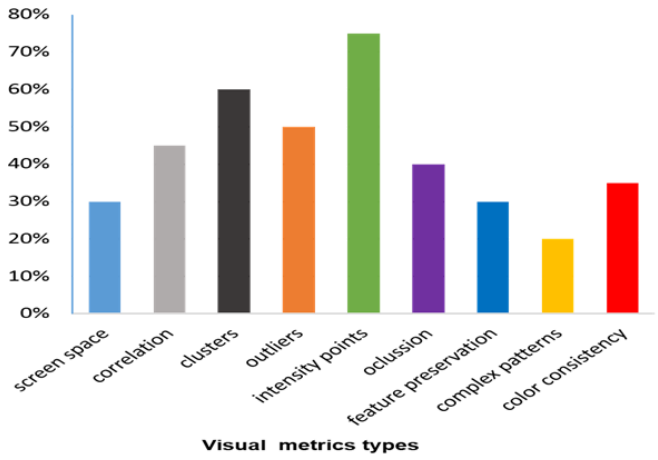
Figure 1. The distribution of data metrics (measuring categories) in visualization literature both in data and image space. Data were collected from different resources and journals such as IEEE, ACM, CGF, Info Vis, TVCG, Scopus, Clarivate Analytic Web of Science and